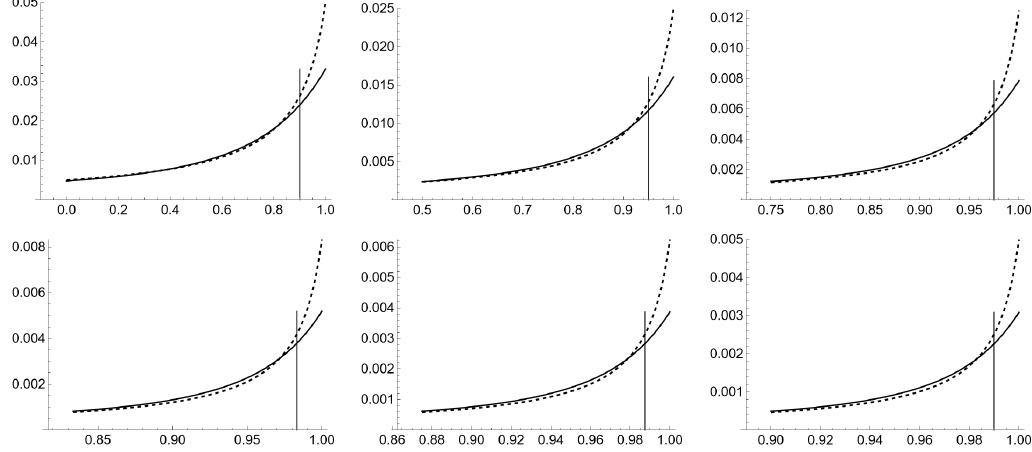
Figure 3 . Graphs of the exact formula (3.30) — the black line, and the approximation (3.33) — the dashed thick line, for N = 20 , 40 , 80 , 120 , 160 , 200 (left to right, top to bottom) in the large mass approximation (4.11) The parameter on the horizontal axis is u = cos ϑ and The vertical line is at u = 1 − 2 /N . We can see that in the large mass approximation the approximation is reliable all the way to this value. As in the figure 2 the u axis is shifted and rescaled such that the relevant region is